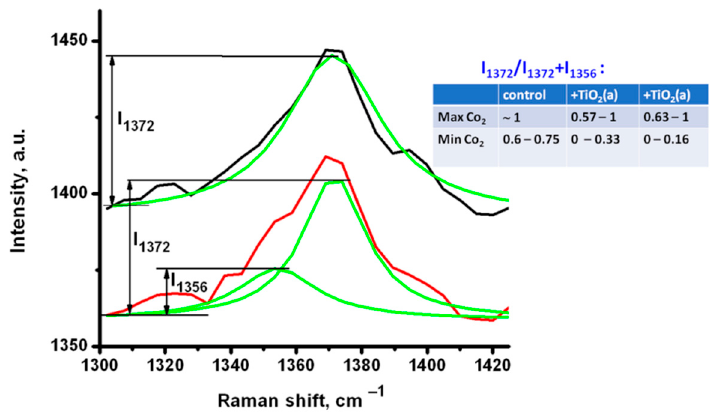
Figure 6. Deconvolution of characteristic Raman spectra of the most oxygenated Hb (I) and the most deoxygenated Hb (II) in an individual RBC; spectra deconvolution using Lorentzian fitting is shown in green. Inset: the variations of intensities ratio for control RBC and RBC treated with TiO 2 are estimated numerically.